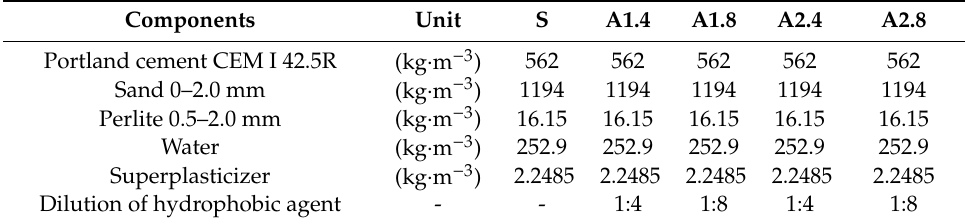
Table 1. Composition of mortars with lightweight